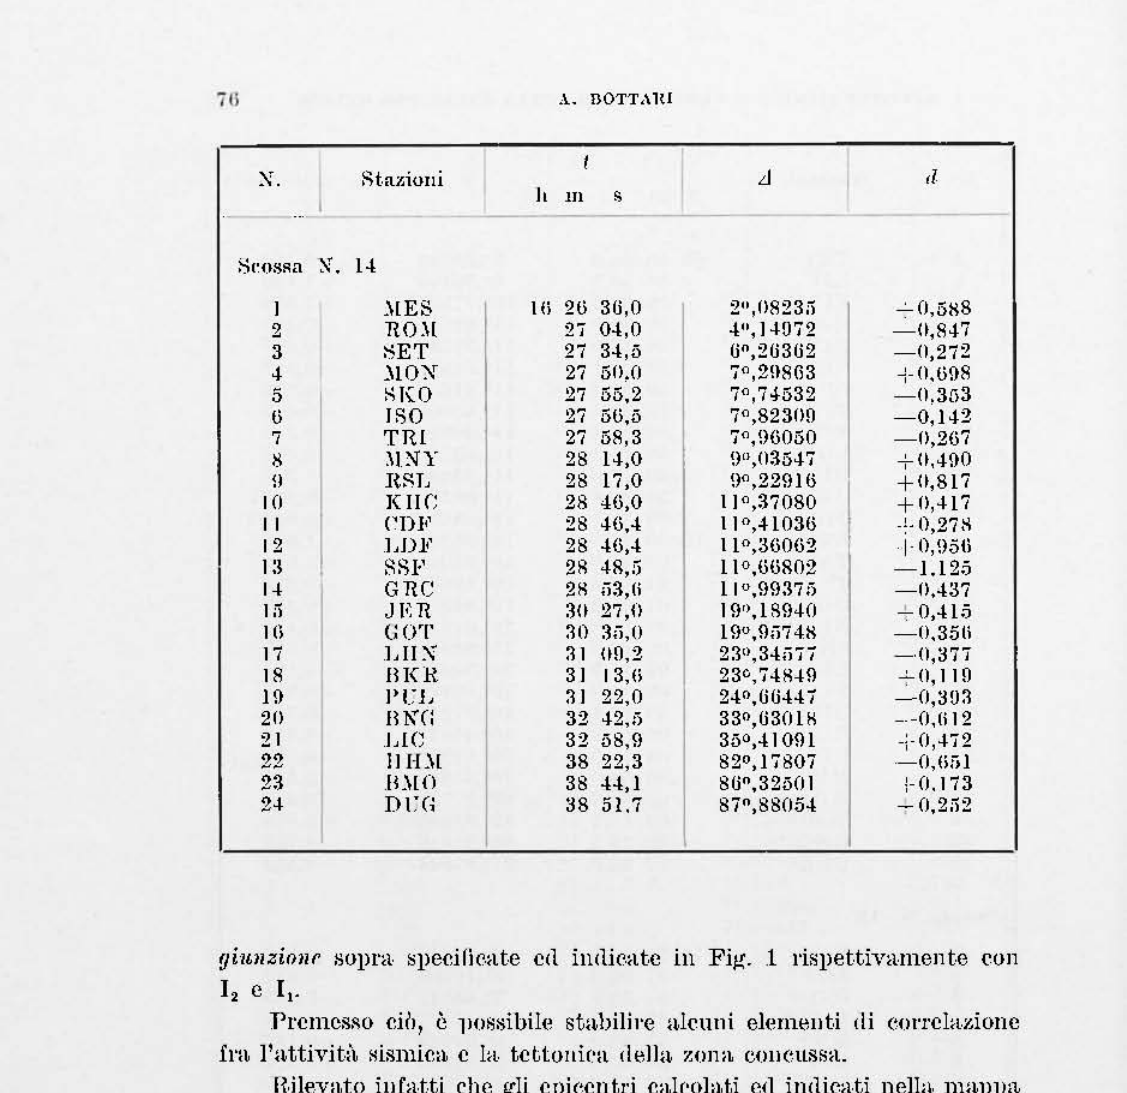
(li Fig. 2 11l'eHentano una (listribuzione pressocch(' rettiliuea, da NE verso 8'V, su un front", di dI'ca :W km, e cou l'estremo (li NE in eorri SllO!)([ellza di J{oceamena e l'estremo di S\V a· S di Pa.rtanna, risulta che detta (lisposiziolle epicentrale è sensibilmente para.Jlela alla. eon gillugente Castelvetl'ano-1!Ltt' l,'inestrelle e si dis('ost.a (la questa di I soli epicentri dei terremoti 2, 4 e 7 non seguono l'andamento gellemle: il S . 2 {\ pratieamellte sulla congiungente :Montevago-Con t.esHa ]~ntellina (h), mcntre il N. ·1 e il N. '7 sono ad \V della. diret.triee Castelvet.l'a.Jlo-.ì\1.te }'ineHtre.Jle (Il) (Fig.